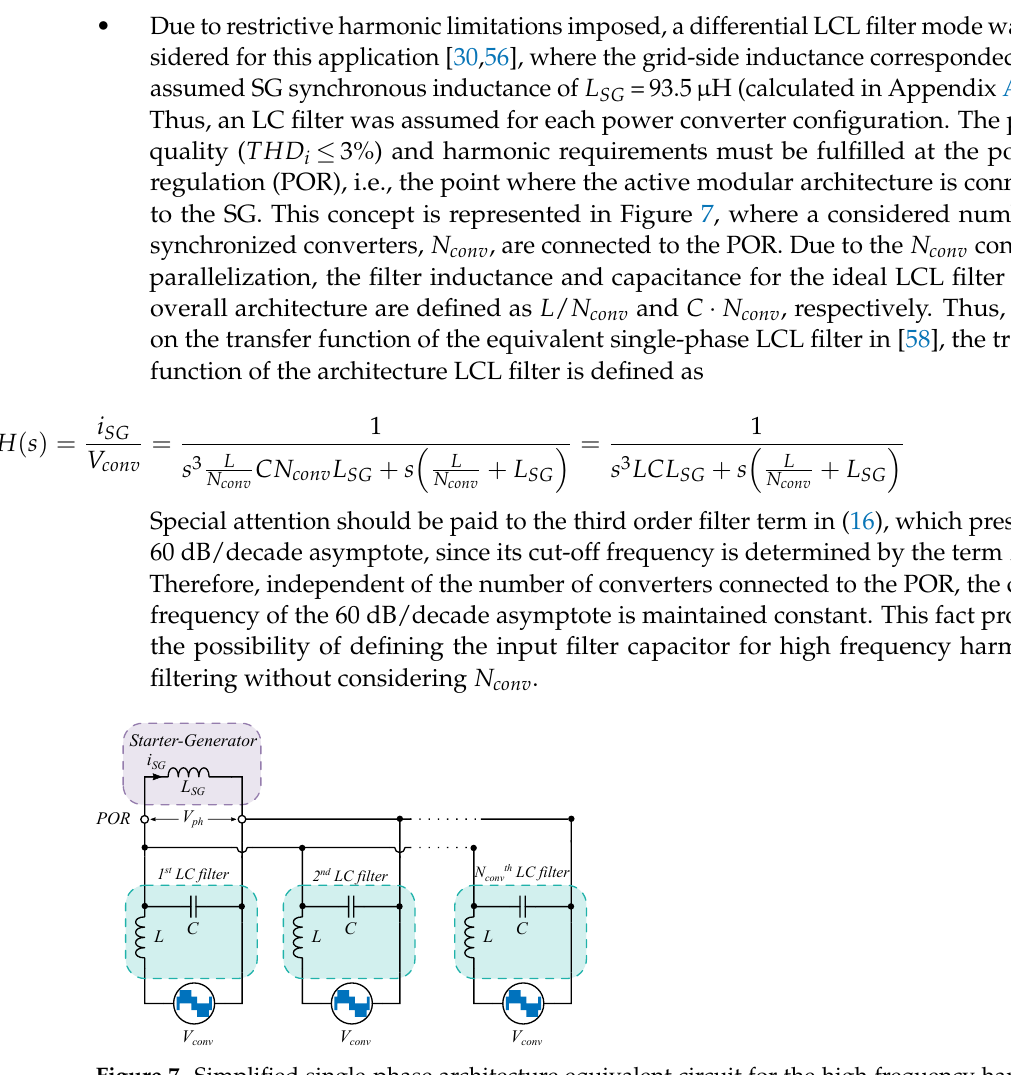
Figure 7. Simplified single-phase architecture equivalent circuit for the high frequency harmonic filtering